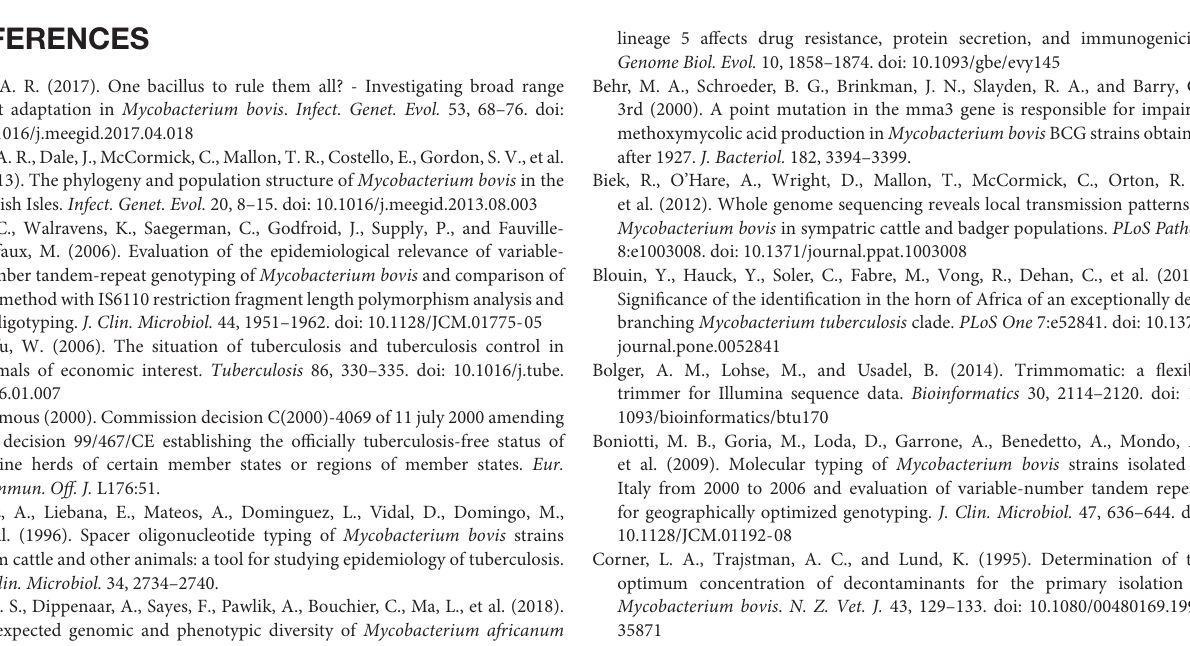
FIGURE S1 | Geographical distribution of the 87 sequenced field isolates of Mycobacterium bovis . The strains were selected on the basis of their spoligotype and MLVA profile that, in different colors, represent all the genetic diversity of French M. bovis strains. This panel includes strains isolated from cattle (circles), goats (triangles), sheep (stars) and wildlife (losanges), pigs (pentagons), wild boar (squares). FIGURE S2 | Comparison of the homoplasy index among the different genotyping methods. HI was calculated with software package PAUP based on the number of observed changes at each character compared to the expected number of changes assuming absence of homoplasy. TABLE S1 | Metadata strain information spoligotype MLVA GenBank Number. TABLE S2 | Sequencing metrics. TABLE S3 | Genome position all SNP. TABLE S4 | Virulence genes information. TABLE S5 | Single nucleotide polymorphism on virulence gene Metadata. TABLE S6 | Virulence gene without SNP. TABLE S7 | The six virulence genes most frequently